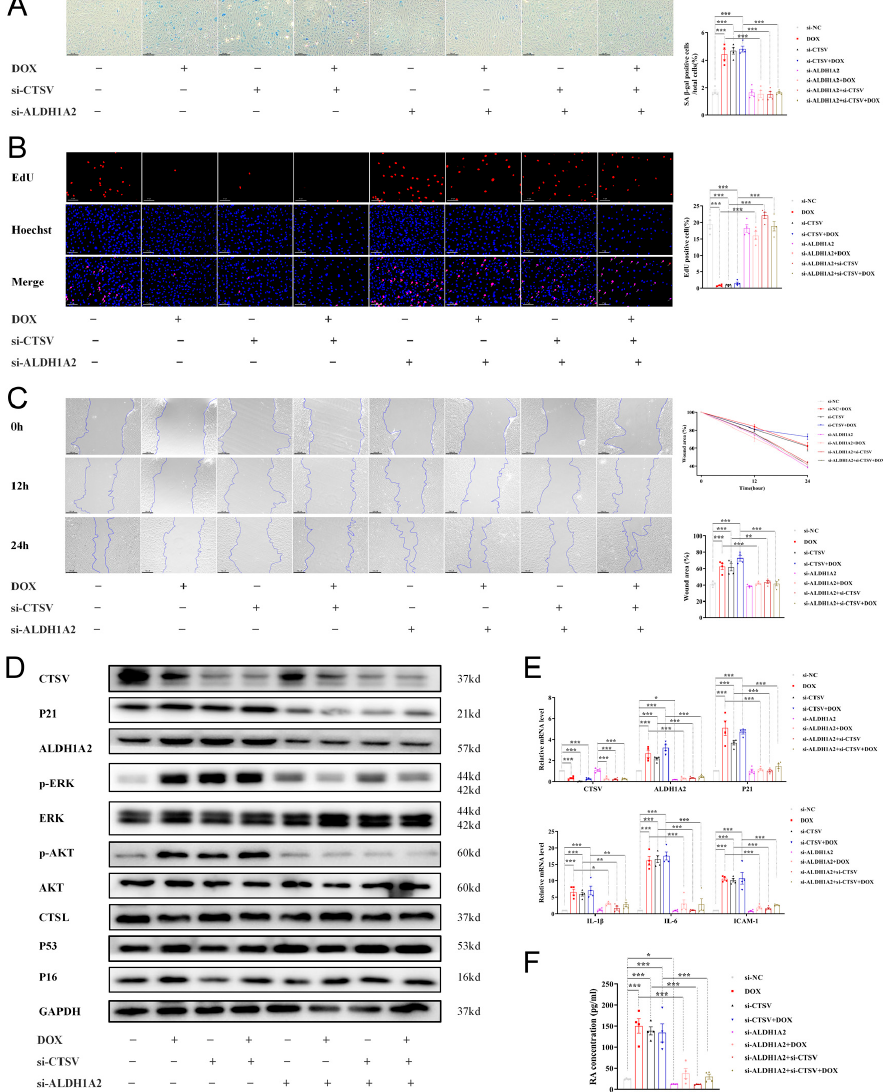
Figure 7. Inhibition of CTSV induces cellular senescence. ( A ) HUVECs were treated with si-negative control (NC), si-CTSV, si-ALDH1A2 or si-CTSV + si-ALDH1A2 for 24 h and simulated with 100 nM doxorubicin (DOX) for 24 h after incubated in complete growth medium for 24 h. SA- β -gal activity was analyzed (blue staining for the senescent cells, scale bar = 50 μ m, n = 4). ( B ) EdU assay of the cell proliferation ability in HUVECs treated with DOX, si-CTSV and si-ALDH1A2 (red staining for the EdU, blue staining for Hoechst, scale bar = 25 μ m, n = 4). ( C ) Representative image of the wound healing assay and the quantification of wound area in HUVECs (scale bar = 100 μ m, n = 4). ( D ) Western blot of CTSV, ALDH1A2, P21, p-ERK1/2, ERK1/2, p-AKT, AKT, CTSL, P53 and P16 in HUVECs treated with DOX and siRNAs ( n = 4). ( E ) Relative mRNA level of CTSV, ALDH1A2, P21, IL-1 β , IL-6 and ICAM-1 ( n = 4). ( F ) RA concentration in HUVECs treated with DOX and siRNAs ( n = 4). Data are presented as mean ± SEM. One-way ANOVA test was used. * p < 0.05, ** p < 0.01, *** p <